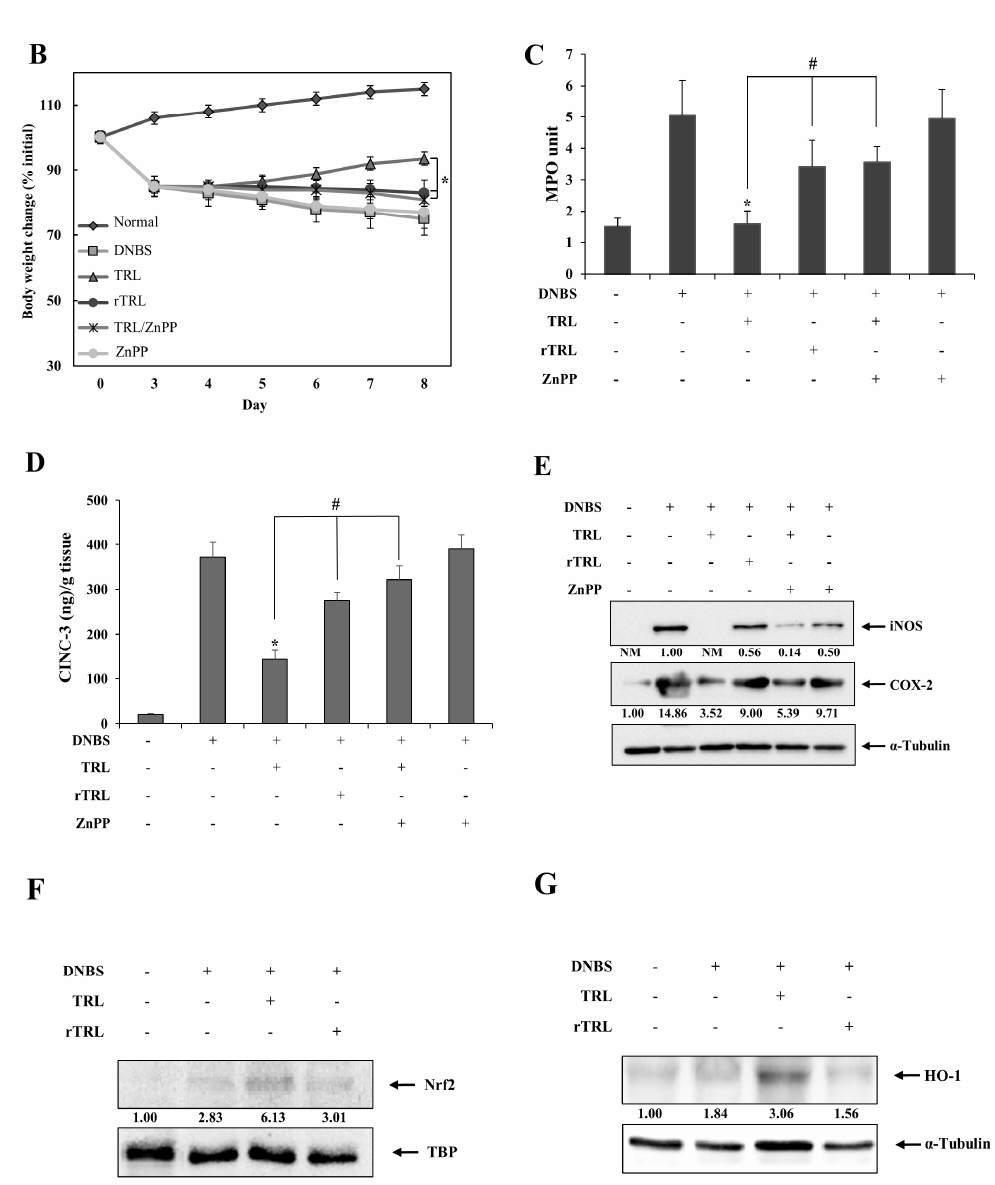
Figure 4. TRL amelioration of rat colitis is partly compromised by either its chemical reduction or co-treatment with an HO-1 inhibitor. Three days after colitis induction by DNBS, drugs were administered to rats once daily, and the rats were euthanized following the seventh treatment. The distal colons of rats were subjected to anti-colitic evaluation. ( A ) Left panel: The colonic damage score (CDS) was assessed using the modified scoring system. Right panel: The serosal and luminal sides of the distal colon were photographed. The images are representative of those obtained from the five rats. ( B ) Rat body weights were measured once a day and body weight change was presented as percent of initial weights. *: p < 0.05 ( n = 5) ( C ) MPO activity was measured in the distal colon (4 cm). ( D , E ) The levels of inflammatory mediators such as CINC-3 ( D ), iNOS, and COX-2 ( E ) were monitored in the distal colon using a CINC-3 ELISA kit and western blotting. ( F , G ) Nuclear Nrf2 and HO-1 protein levels in the distal colon were monitored 2 h (for Nrf2) and 8 h (for HO-1) after rectal administration of either 200 µ M of TRL or rTRL (in 500 µ L PBS) by western blotting. For western blotting in ( E – G ), equivalent loading of proteins was verified using TATA box protein (TBP) for nuclear Nrf2 protein and α -tubulin for cytosolic proteins. Western blot results are representative of blots obtained from the distal colons of five rats. NM, not measurable. The data in ( A – C ) are expressed as the mean ± standard deviation ( n = 5). *: p < 0.05 vs. control; #: p < 0.05